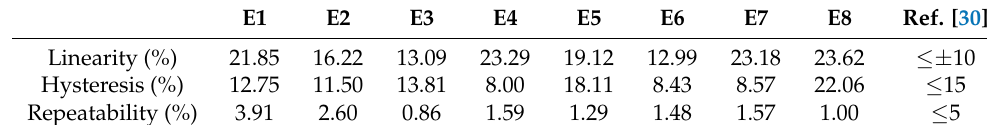
Table 2. Performance parameters of the sensing elements.